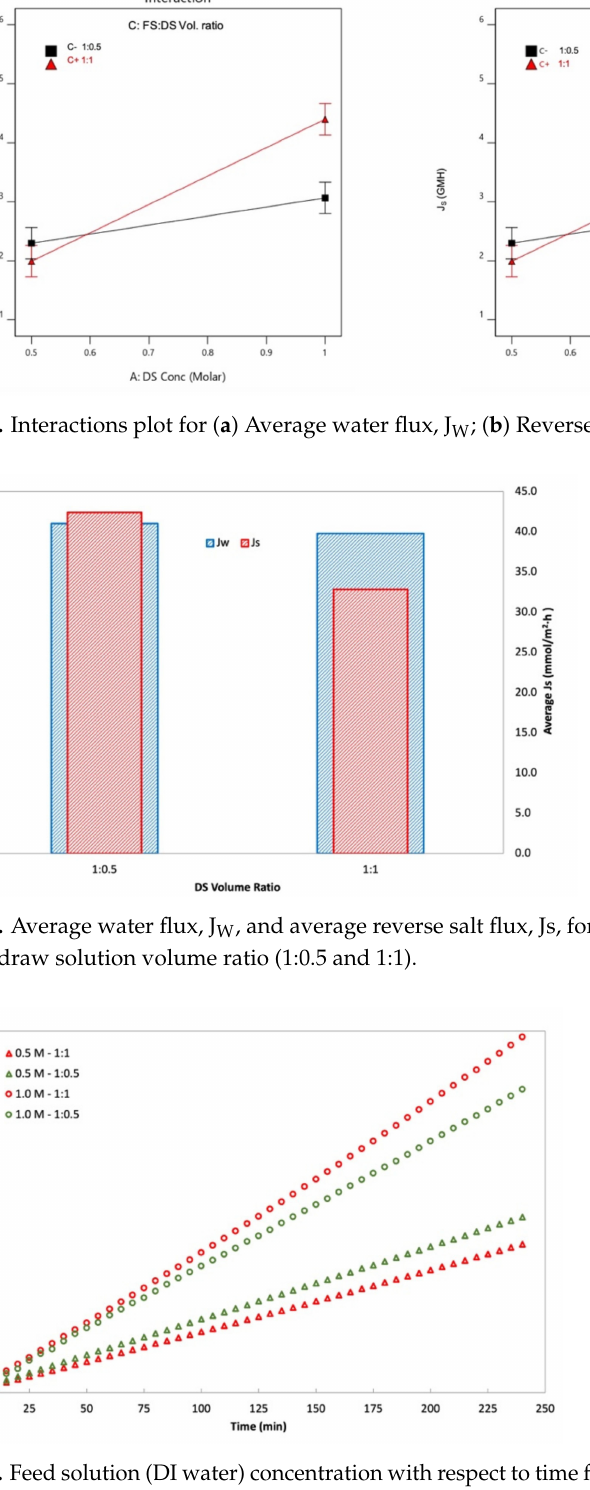
Figure 7. Feed solution (DI water) concentration with respect to time for varying NaCl concentrations and FS:DS volume ratio (0.5 M NaCl with a volume ratio of 1:0.5; 0.5 M NaCl with a volume ratio of 1:1; 1.0 M NaCl with a volume ratio of 1:0.5; 1.0 M NaCl with a volume ratio of